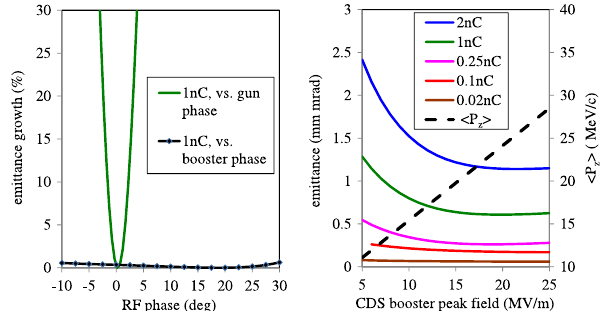
FIG. 10. Simulatedemittancegrowthasafunctionoftherfphase of the gun and the booster (left plot). Both phases are calculated w.r.t. the phase of the maximum mean momentum gain. Right plot—simulated emittance as a function of the booster peak field. The final mean momentum of the electron beam is plotted at the right